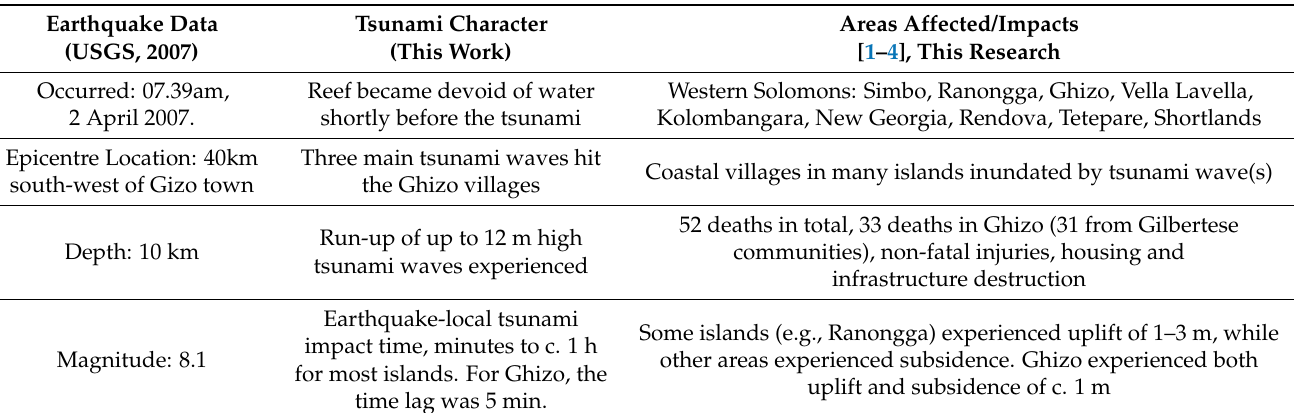
Table 1. Summary characteristics of the April 2007 Western Solomons earthquake, tsunami and impacts. Earthquake